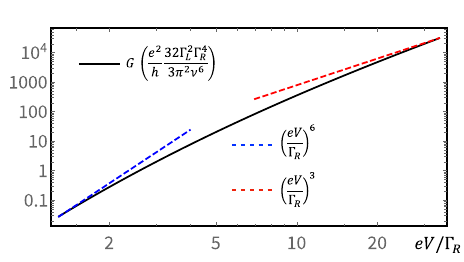
Fig. 2 | The schematic diagrams of high-order coherent operators. a Process A (red arrow) and B (blue arrow) are coherent in the extremely low-temperature regime T ≪ Γ seq ≪ ν , where they together construct the coherent double Majorana-